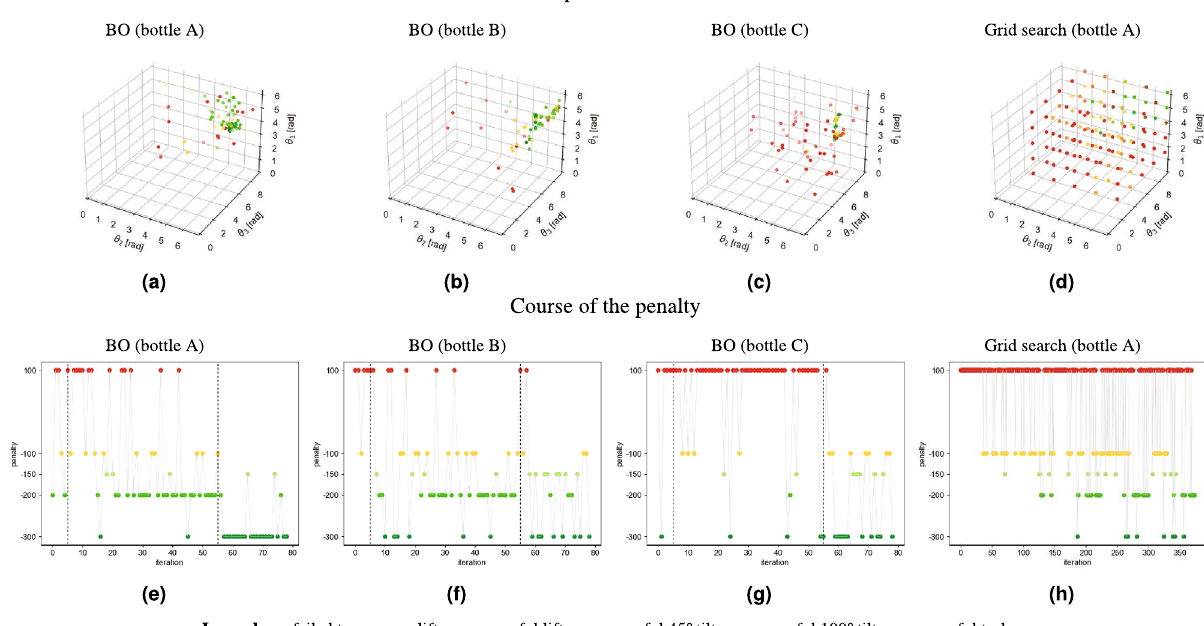
evaluations collected in the training of the individual models are shown, whereas in ( d ) the result of the evenly spaced exploration of the domain is reported. In the bottom line, the course of the penalty during the training procedure are shown: ( e ), ( f ), ( g ) report the results of the BO runs, and ( h ) the outcome of the grid search. The vertical dashed lines in ( e ), ( f ) and ( g ) demarcate the phases of the training (in order: initialization, first and second